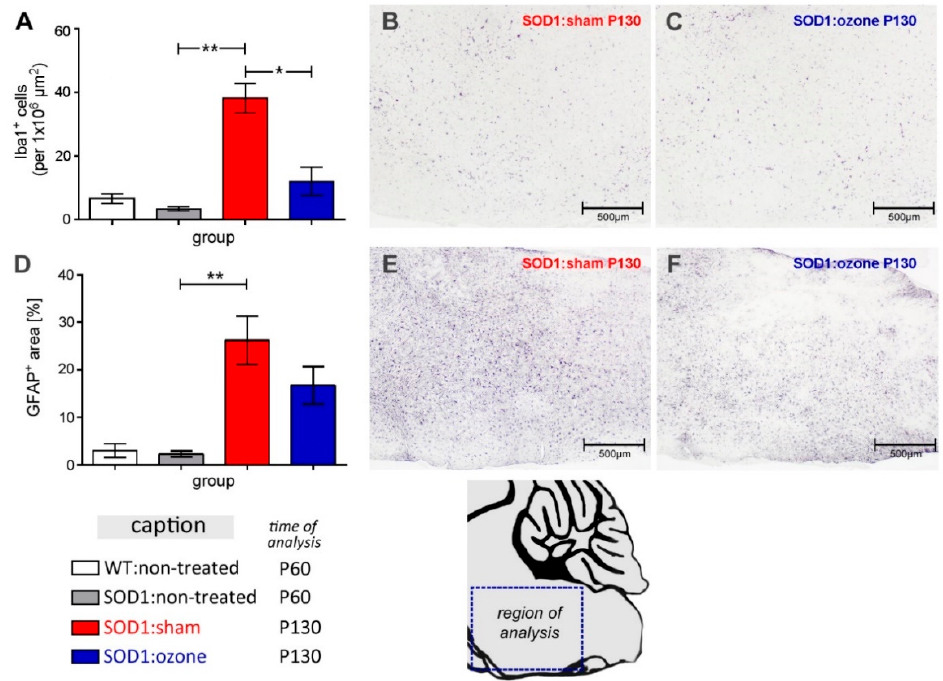
Figure 4. Neuroinflammation in the brainstem. Evaluation of ( A – C ) Iba-1 immunoreactivity as a measure for microglia proliferation, and ( D – F ) GFAP-ir for astroglia hypertrophy. Brainstem cartoon shows the region of quantitative analysis depicted in A and D, as well as the microscopic images of representative immunostaining for Iba1 ( B , C ) and GFAP ( E , F ). Differences between groups ( n = 3 for all groups) were analyzed using an unpaired t-test with Welch’s correction. *, p < 0.05; **, p < 0.01.